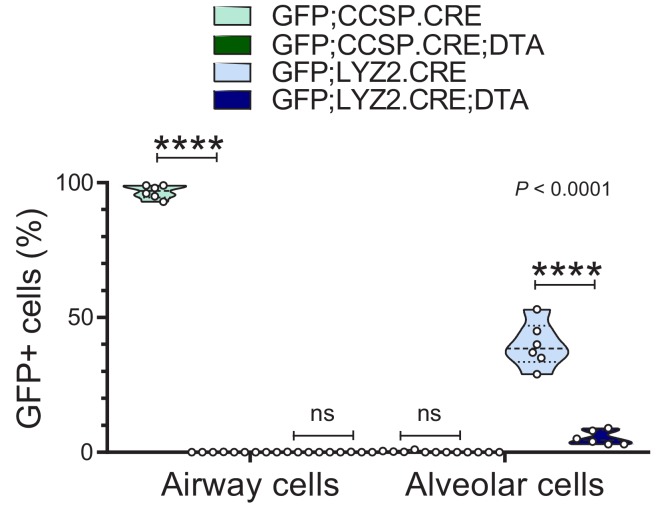
Triple transgenic mouse models for validation of genetic pulmonary lineage ablation: data summary.Violin plot of GFP-labeling of lung sections of 12-week-old mice from Figure 5—figure supplement 1 (n = 6/group). Note the complete ablation of airway cells in GFP;CCSP.CRE mice and the persistence of some GFP-labeled alveolar macrophages in GFP;LYZ2.CRE;DTA mice. Measurements were from at least five non-overlapping tumor, airway, or alveolar fields/lung. P, overall probability, two-way ANOVA. ns and ****: p>0.05 and p<0.0001, respectively, for the indicated comparisons by Bonferroni post-tests.10.7554/eLife.45571.058Figure 5—figure supplement 2—source data 1.Data of GFP+ cells in airways and alveoli of GFP;CCSP.CRE, GFP;CCSP.CRE;DTA, GFP;LYZ2.CRE and GFP;LYZ2.CRE;DTA mice.